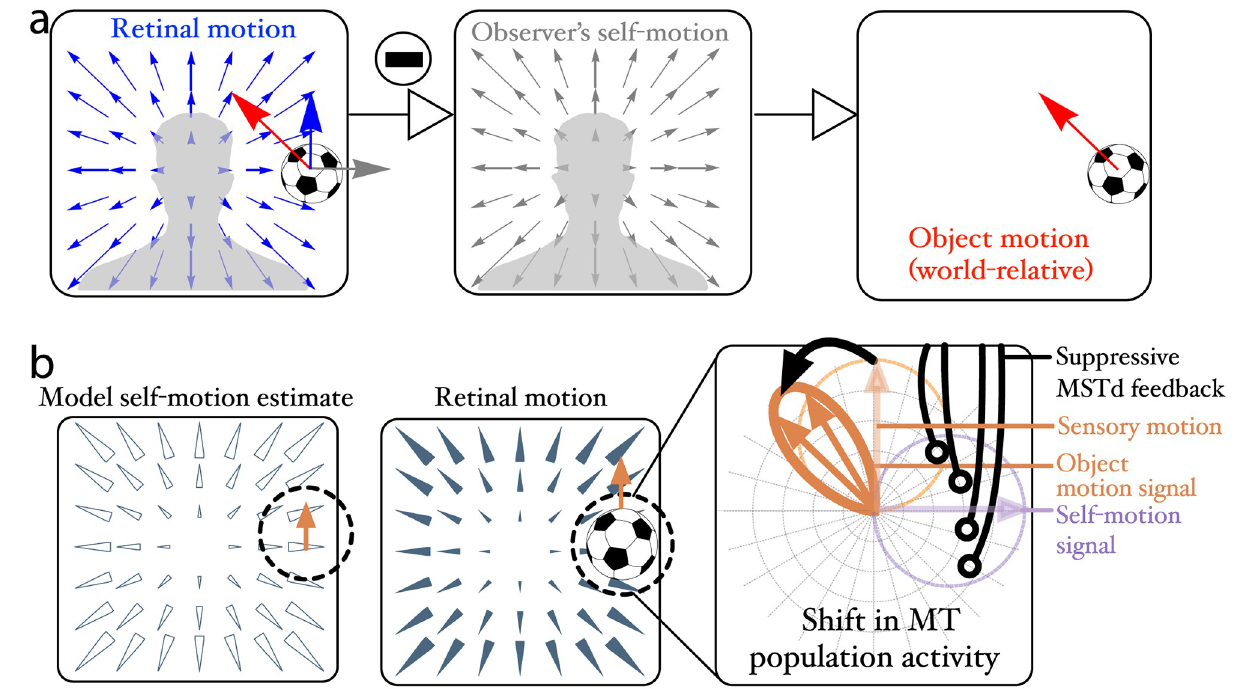
Fig 1. (a) Optic flow components on the retina of a mobile observer. The retinal motion (blue, left panel) is the sum of motion created through self- motion relative to world-fixed stationary environment (center panel) and the motion created by objects that move independently from the observer (red, right panel). The visual system could recover the world-relative motion of objects (red arrow, left and right panels), by subtracting the self-motion component (center panel) from the retinal pattern (left panel). (b) Neural algorithm proposed by Layton & Fajen [4] to recover world-relative object motion. The call-out on the right is a polar plot showing direction responses to the moving object. MSTd cells that respond to the observer’s self-motion send feedback to suppress MT cells (light blue region, right panel) that signal the retinal motion (light orange region, right panel) consistent with the preferred MSTd tuning (open arrows, left panel). Suppression shifts the direction signaled by the MT population toward the world-relative direction (dark orange, right panel).